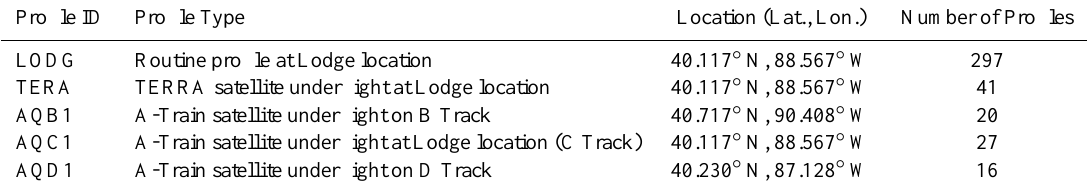
Table 3. AAO profile locations and